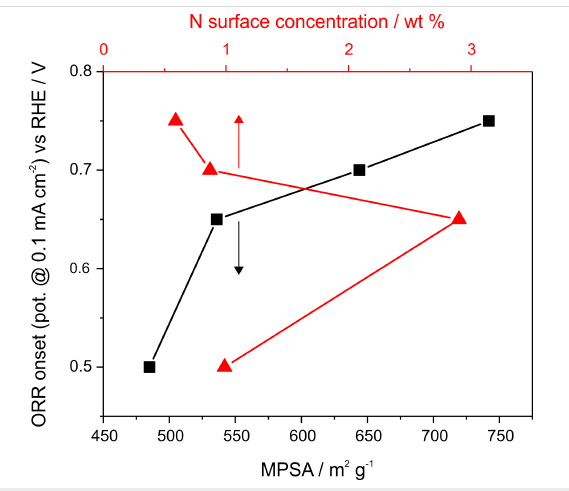
Figure 9: ORR onset potential (potential value at 0.1 mA·cm − 2 ) as a function of the micropore surface area (MPSA) and N surface concen- tration (XPS) for the NCS